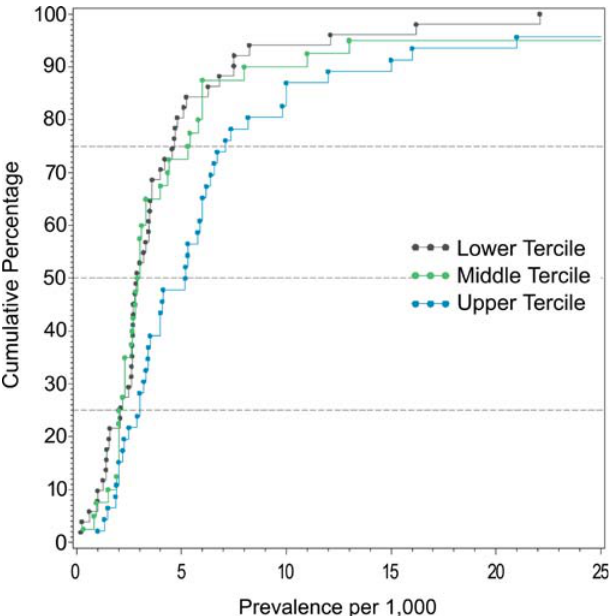
Figure 14. Cumulative Plots of Combined Prevalence Estimates per 1,000 for Persons by Tercile of Quality Score DOI: